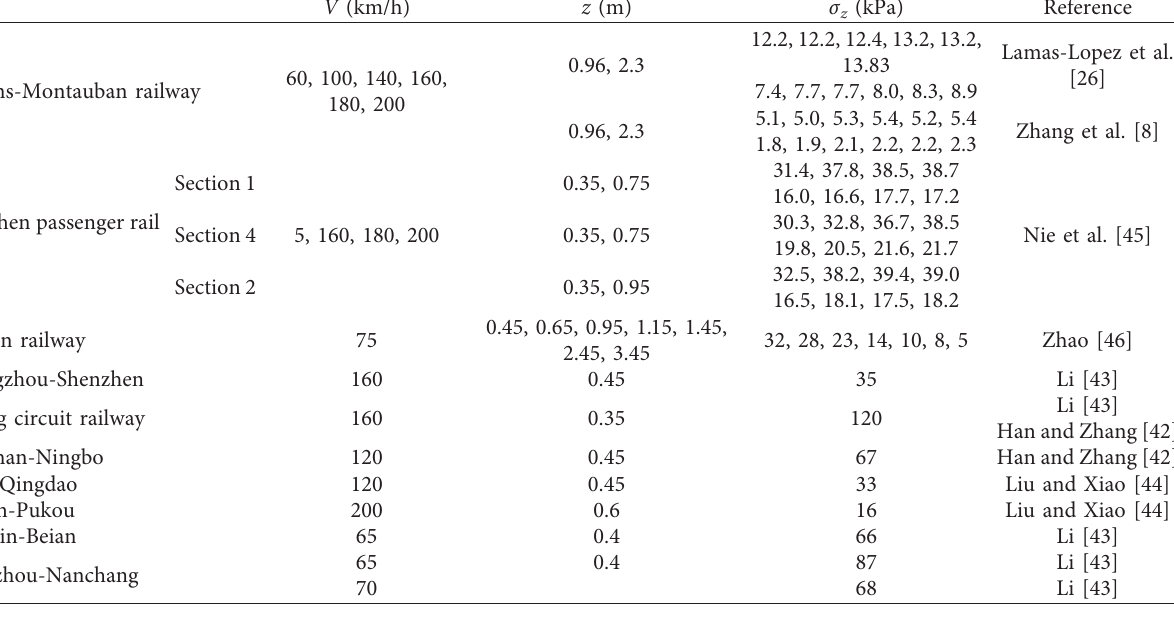
Table 2: Field measurements of fourteen cases used.